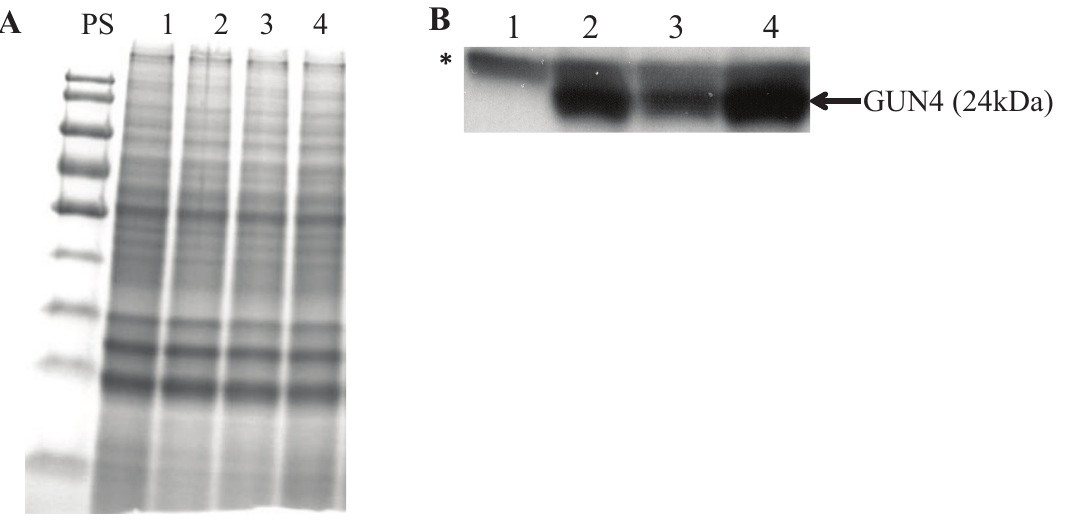
Figure 12. SDS-PAGE and Western analyses. ( A ) A stained protein gel. Lanes 1, 2, 3 and 4 represent gun4-II , gun4-19 , 4A + and gun4-27 , respectively. PS denotes prestained molecular weight protein ladder. Total cell extract of different strains were loaded on equal Chlorophyll (Chl) basis (4 µg of Chl). ( B ) Western analyses using a GUN4 antibody generated against the Chlamydomonas mature full length GUN4 protein. Lanes 1, 2, 3 and 4 represent gun4-II , gun4-19 , 4A + and gun4-27 , respectively. GUN4 (24 kDa) protein detected by the antibody is labeled. * denotes a 25 kDa protein detected non-specifically by the GUN4